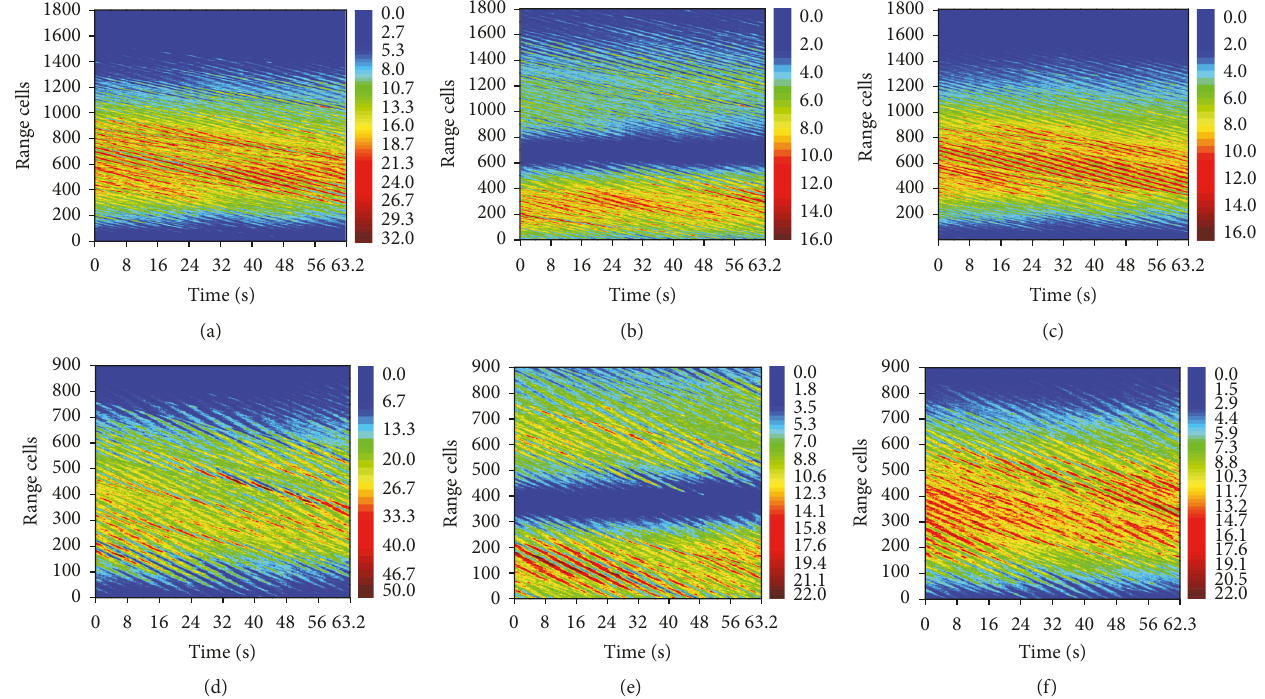
Figure 7: The images of estimated texture components in range against time format: (a) sum channel and elevation and azimuth difference channels for DS1. ((d)–(f)) Sum channel and elevation and azimuth difference channels for DS2.